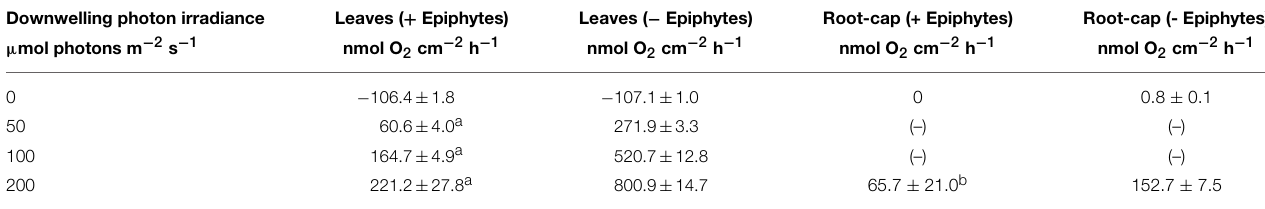
TABLE 1 | O 2 fluxes across the leaf surface and radial O 2 loss from the root-cap ( ∼ 1mm from the root-apex). Downwelling photon irradiance